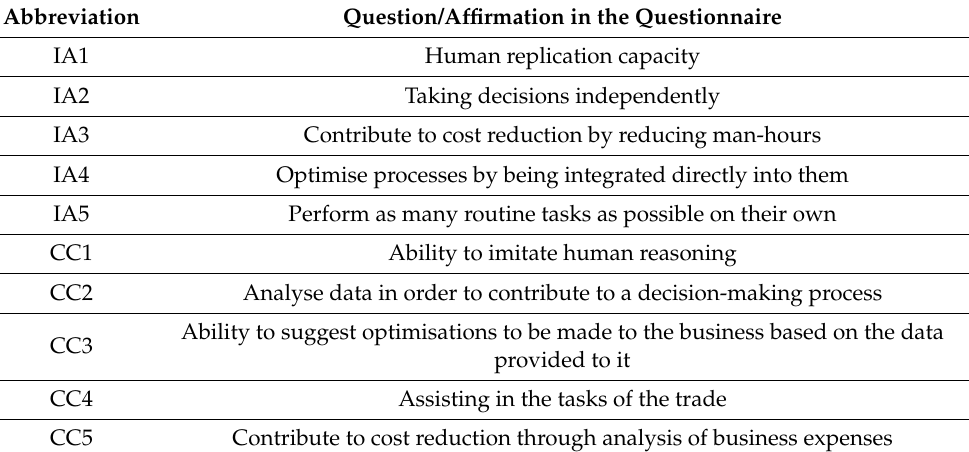
Table 7. Statements to be evaluated from 1 to 5, regarding their level of importance and respec- tive abbreviations.